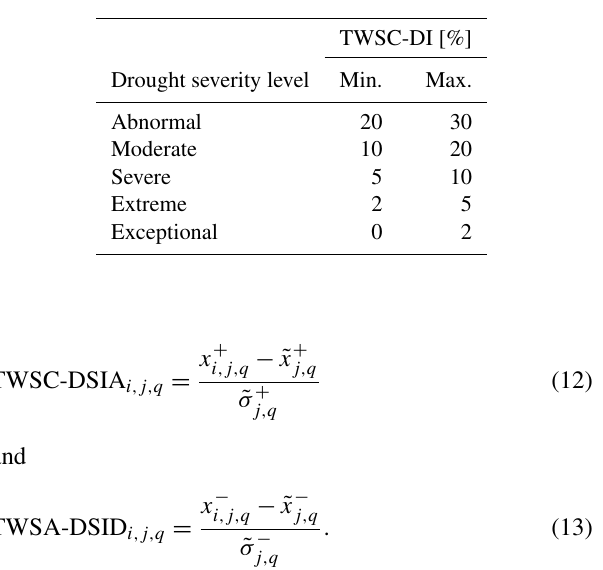
Table 2. Drought severity level of TWSC-DI (Houborg et al., 2012). The values of TWSC-DI are given in